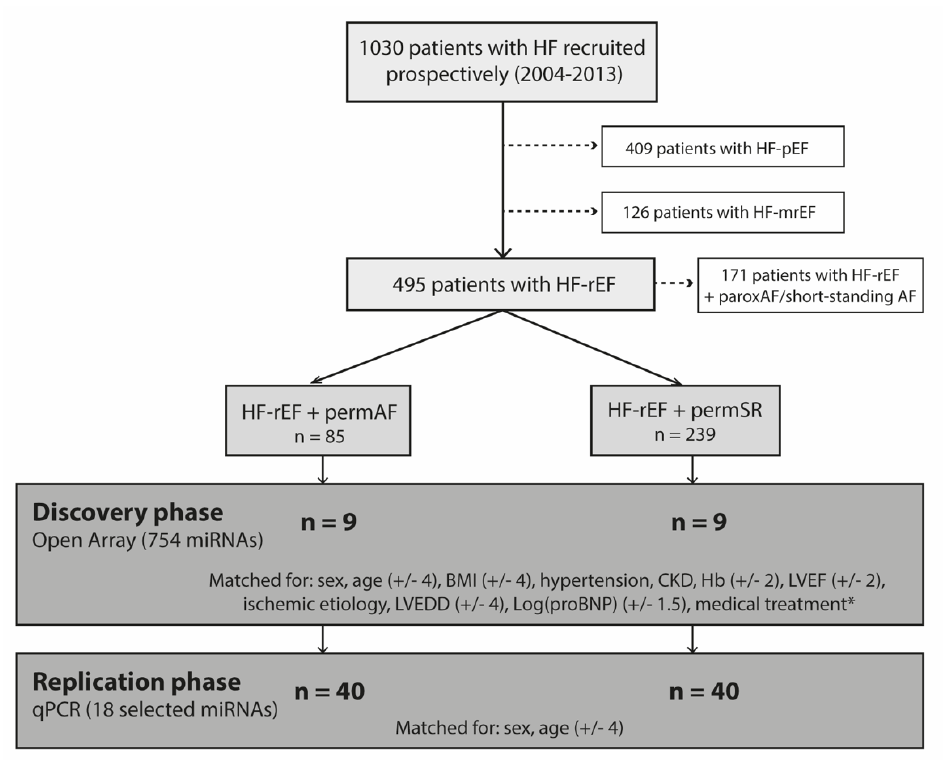
Figure 6. Study design. Of 495 patients with HFrEF, 18 (9 with permAF and 9 with SR) were selected for the discovery phase, and 80 (40 per group) for the replication phase. Matching variables for each phase are presented, with the accepted range in parenthesis. Abbreviations: HF-pEF, mrEF, and rEF: heart failure with preserved (pEF), mid-range (mrEF) and reduced ejection fraction (rEF), respectively, according to the ESC guidelines; (41) permAF: permanent AF; SR: permanent sinus rhythm (no history of past or present AF); BMI: body mass index; CKD: chronic kidney disease; Hb: hemoglobin; LVEF: left ventricular ejection fraction; LVEDD: left ventricular end-diastolic diameter; Log(proBNP): pro-BNP values at baseline in Log expression; * included matching for treatment with betablockers, angiotensin-converting-enzyme inhibitors (ACEI), angiotensin-receptor blockers (ARB), and diuretics.